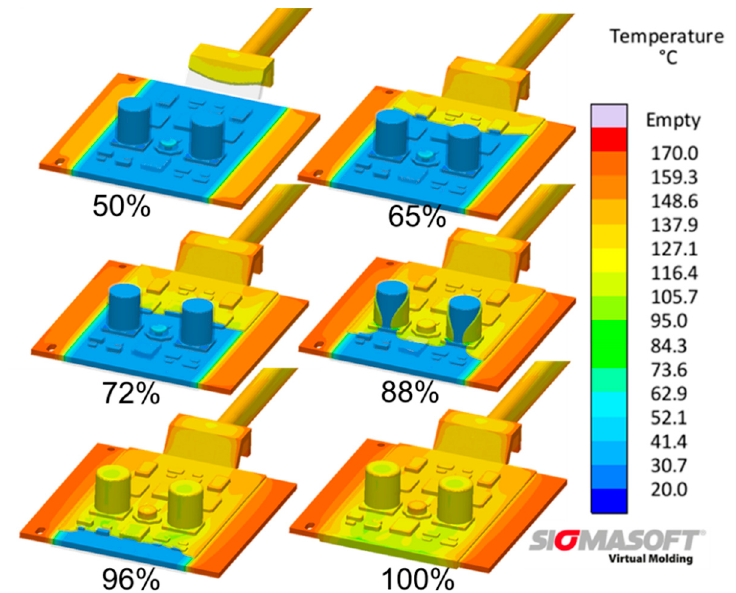
Figure 3. Series of filling behavior (with the % of cavity filled including the runner system) during the simulated injection molding process. The simulation shows a near to uniform filling behavior with a sufficiently attained melt temperature ( ∼ 130 °C).